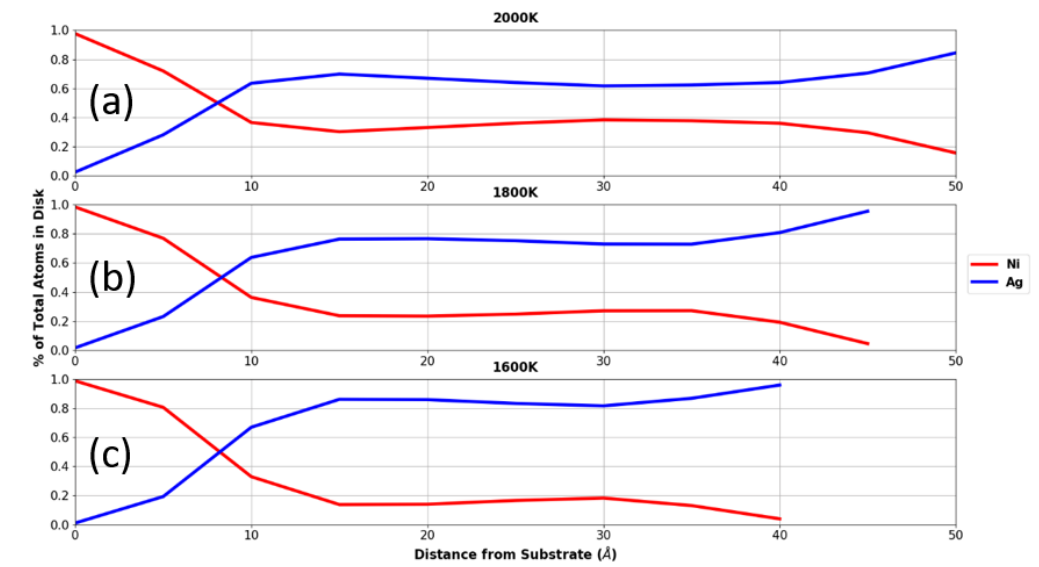
Figure 10. Atomic concentration distribution analysis of the droplets at ( a ) 2000 K, ( b ) 1800 K, and ( c ) 1600 K on substrates as a function of the distance from the substrate.